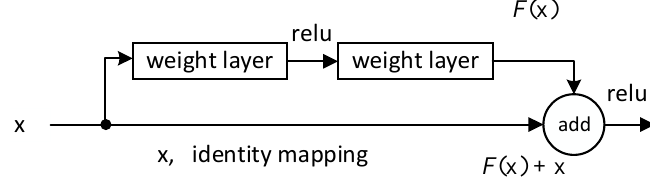
Figure 7. The structure of a residual block.